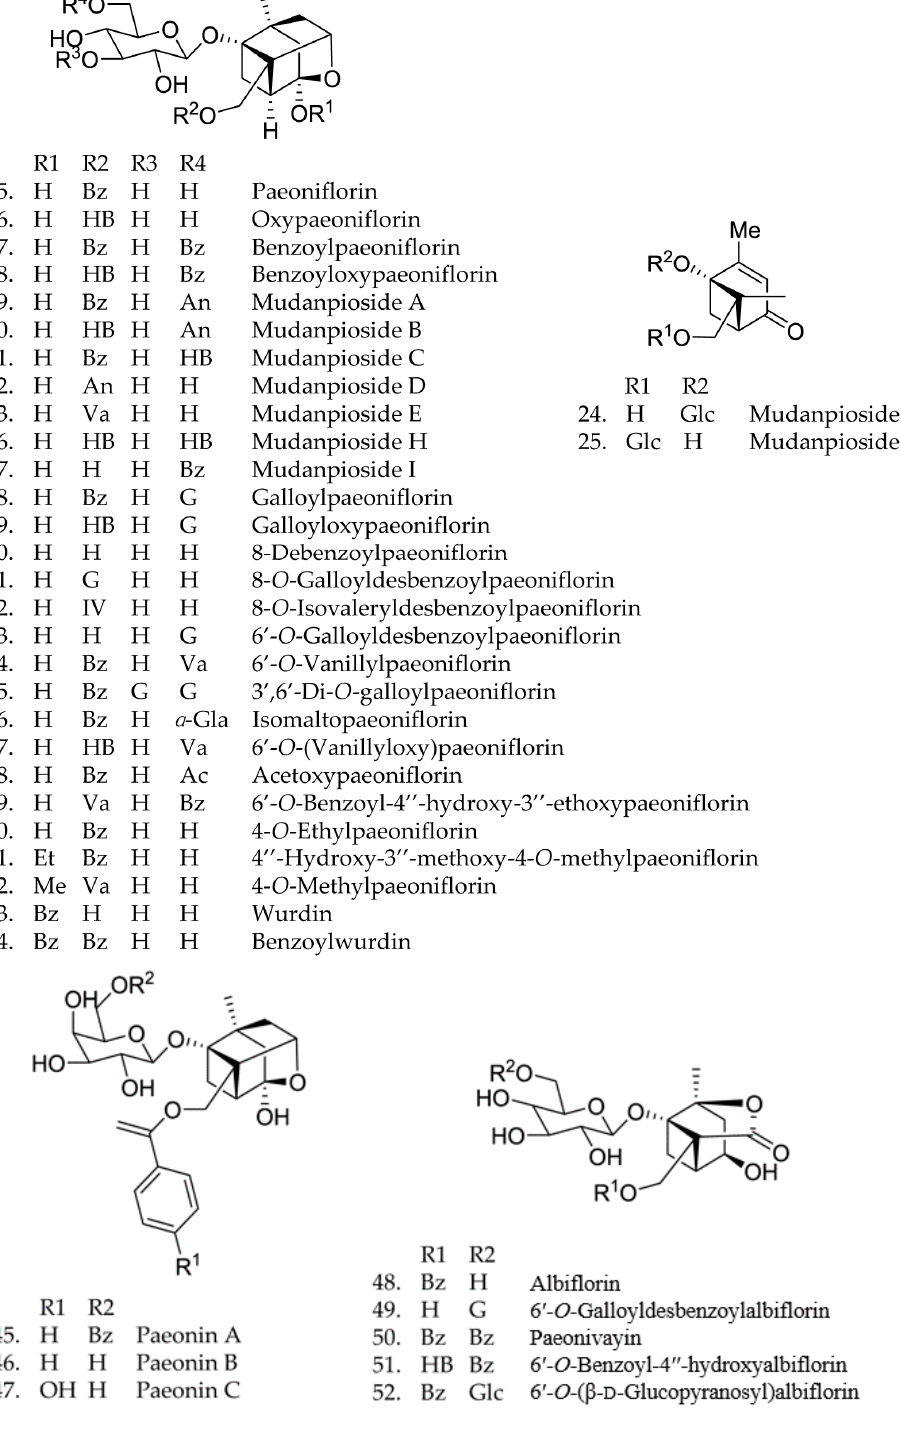
Figure 3. Cont. Figure 3. Cont